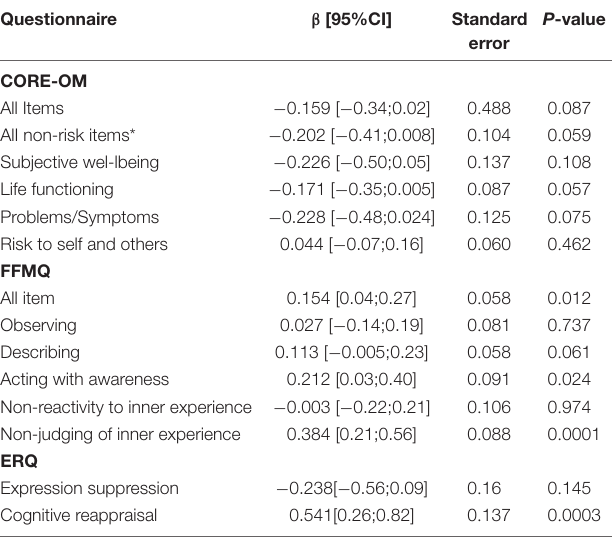
TABLE 3 | Linear mixed model: for each questionnaire β coefficient with its 95%CI, standard error, and P -value for the null hypothesis of β = 0 are